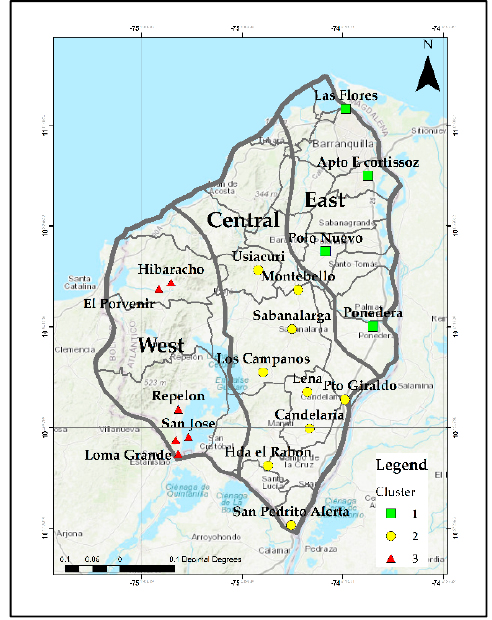
Figure 4. Latitude and longitude vs. asymmetry coefficient.